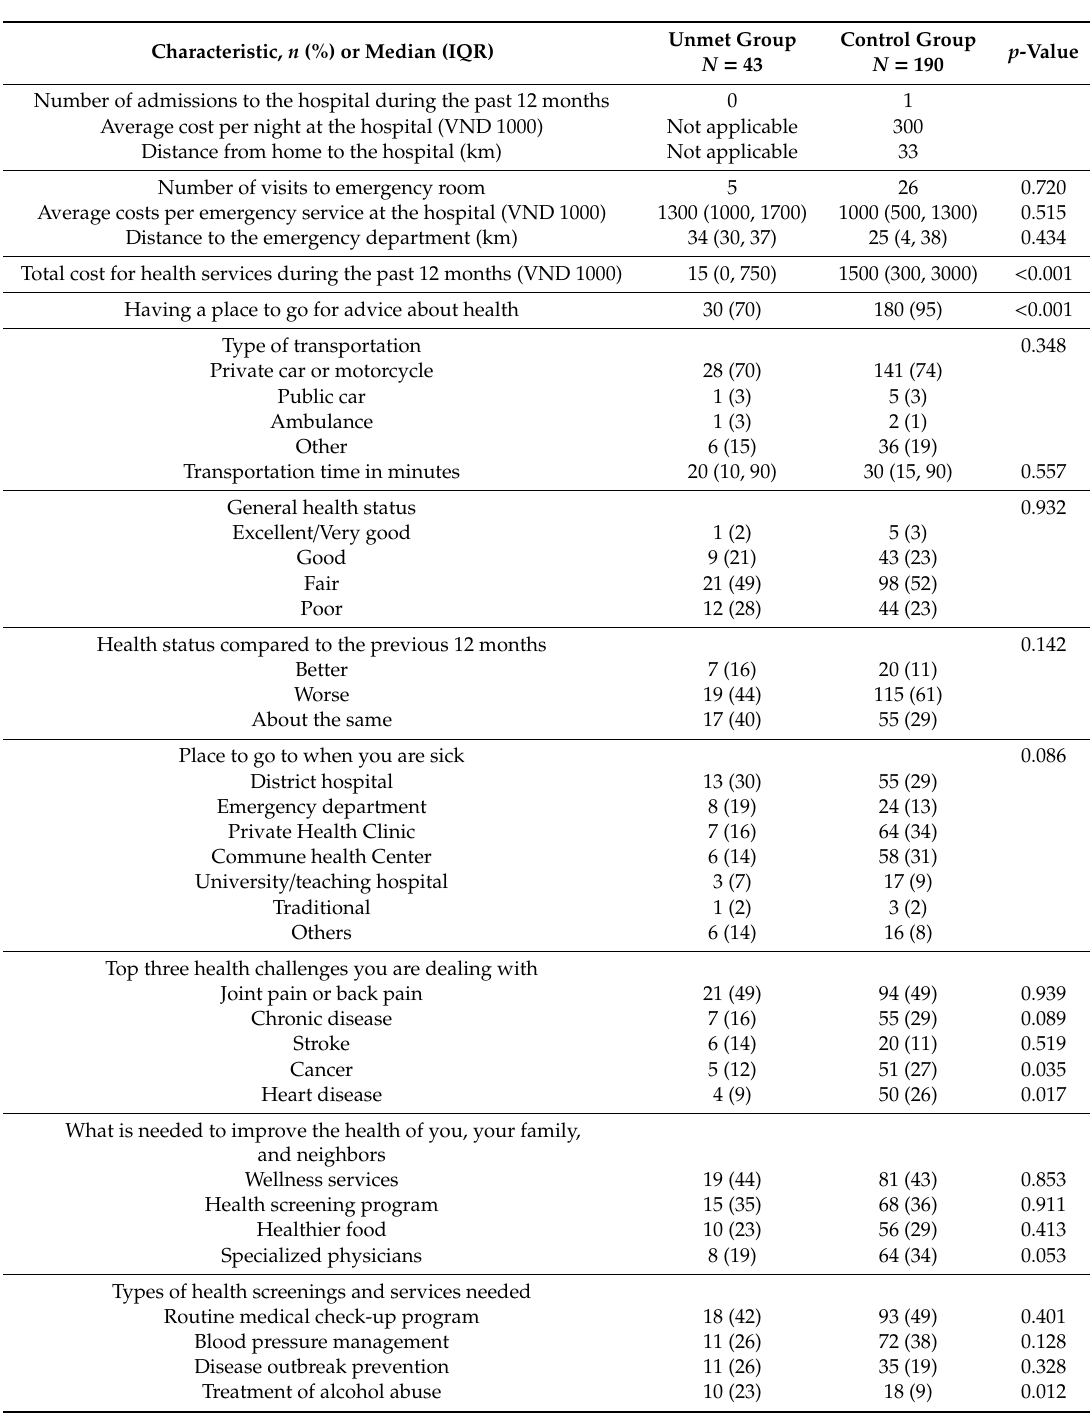
Table 2. Healthcare utilization and healthcare service